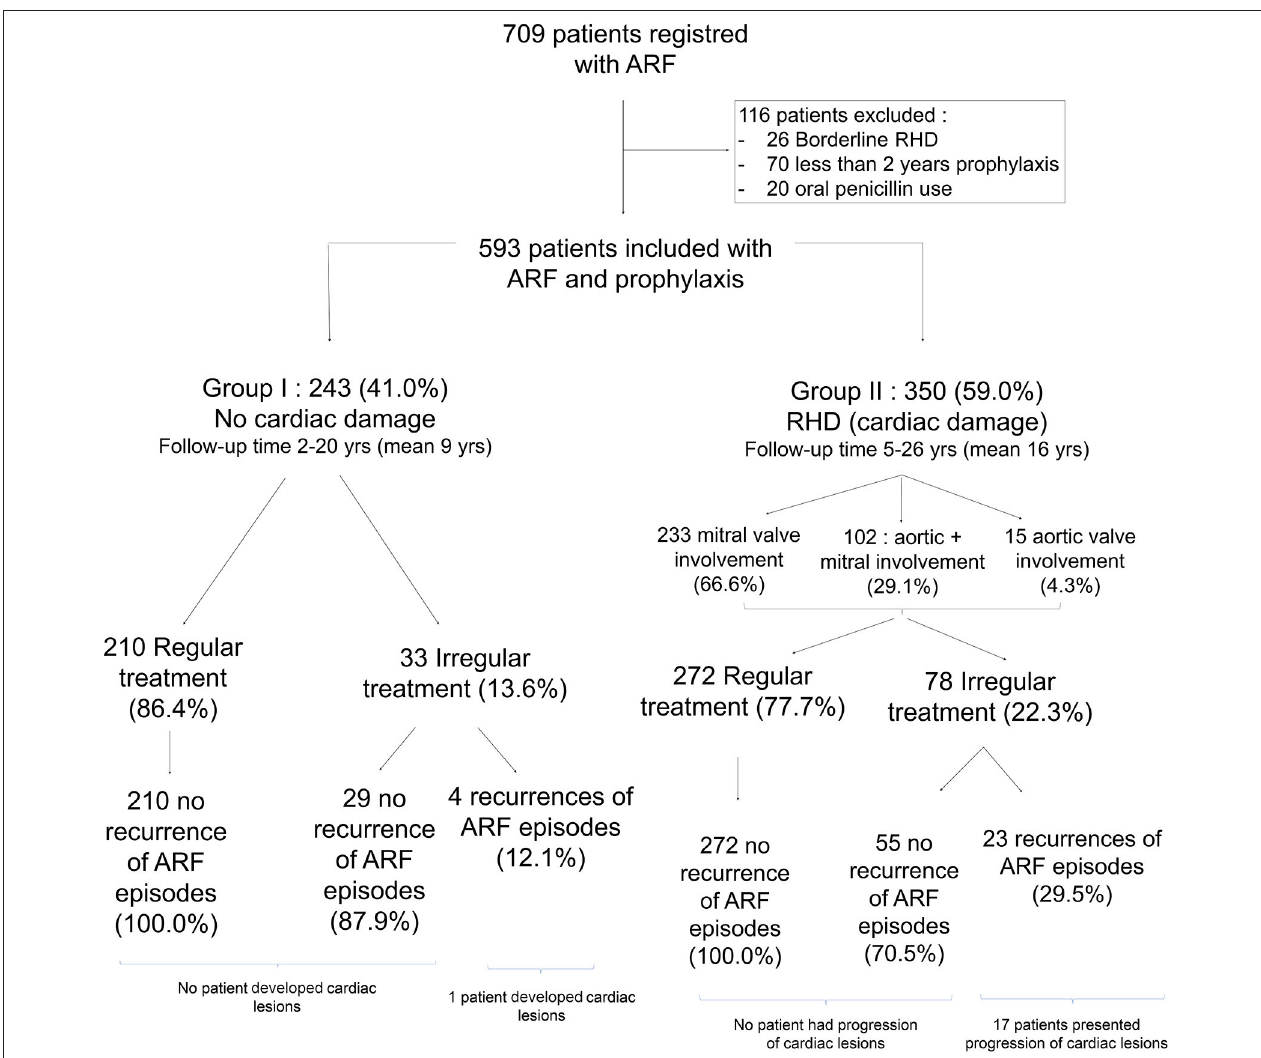
FIGURE 1 | Follow-up of 613 rheumatic patients undergoing prolonged secondary prophylaxis.